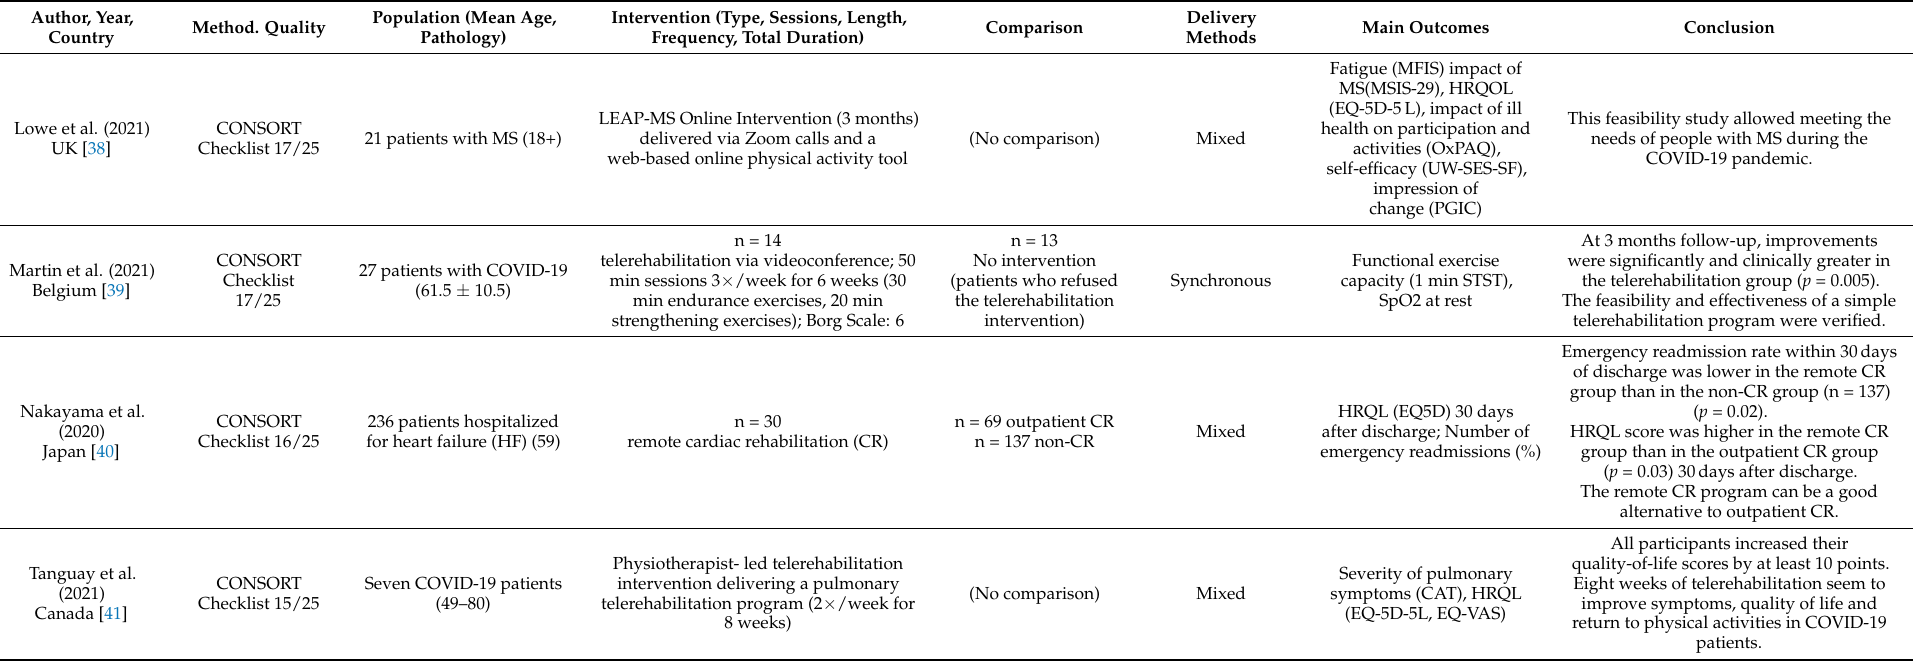
Table 3. Characteristics of the exploratory studies (feasibility and pilot studies) included in the